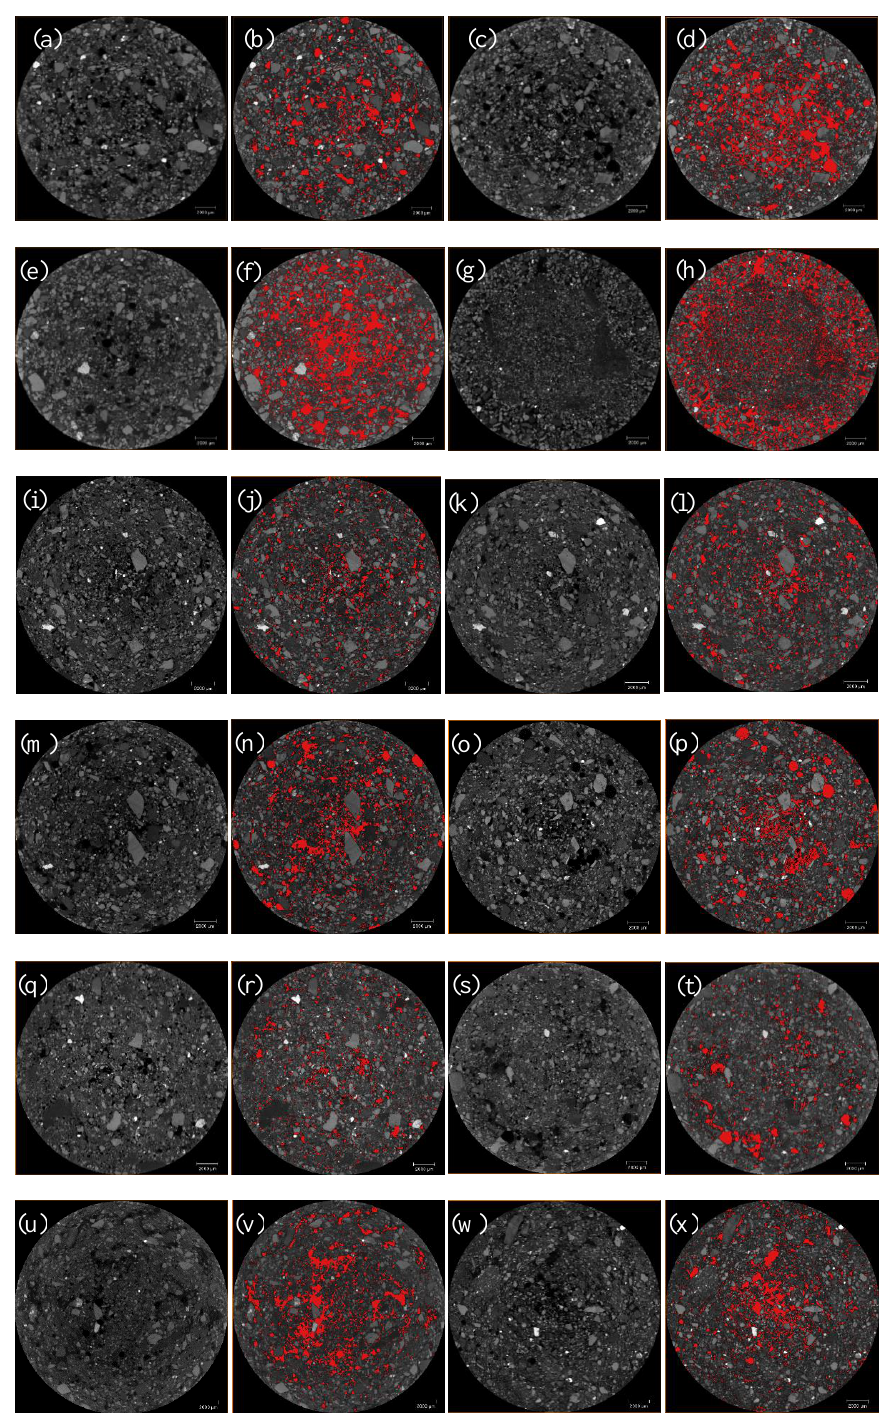
Figure 6. Pore threshold segmentation of the three fine-grained tailings sands. ( a , b ) First-level head of 30% fine content; ( c , d ) Second-level head of 30% fine content; ( e , f ) Third-level head of 30% fine content; ( g , h ) Fourth-level head of 30% fine content; ( i , j ) First-level head of 50% fine content; ( k , l ) Second-level head of 50% fine content; ( m , n ) Third-level head of 50% fine content; ( o , p ) Fourth-level head of 50% fine content; ( q , r ) First-level head of 70% fine content; ( s , t ) Second-level head of 70% fine content; ( u , v ) Third-level head of 70% fine content; ( w , x ) Fourth-level head of 70% fine